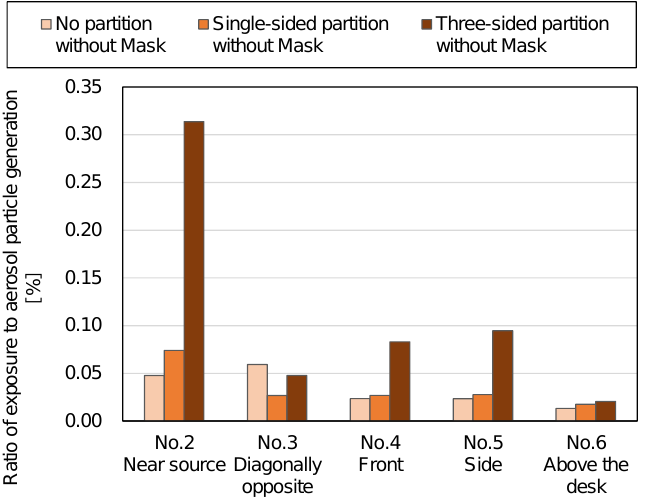
Figure 6. Effect of partition shape (without mask) [21].